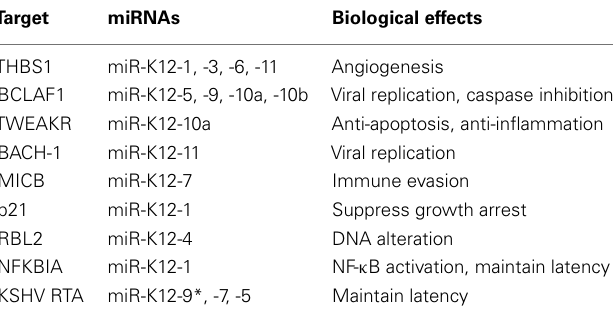
Table 2 | Summary of KSHV